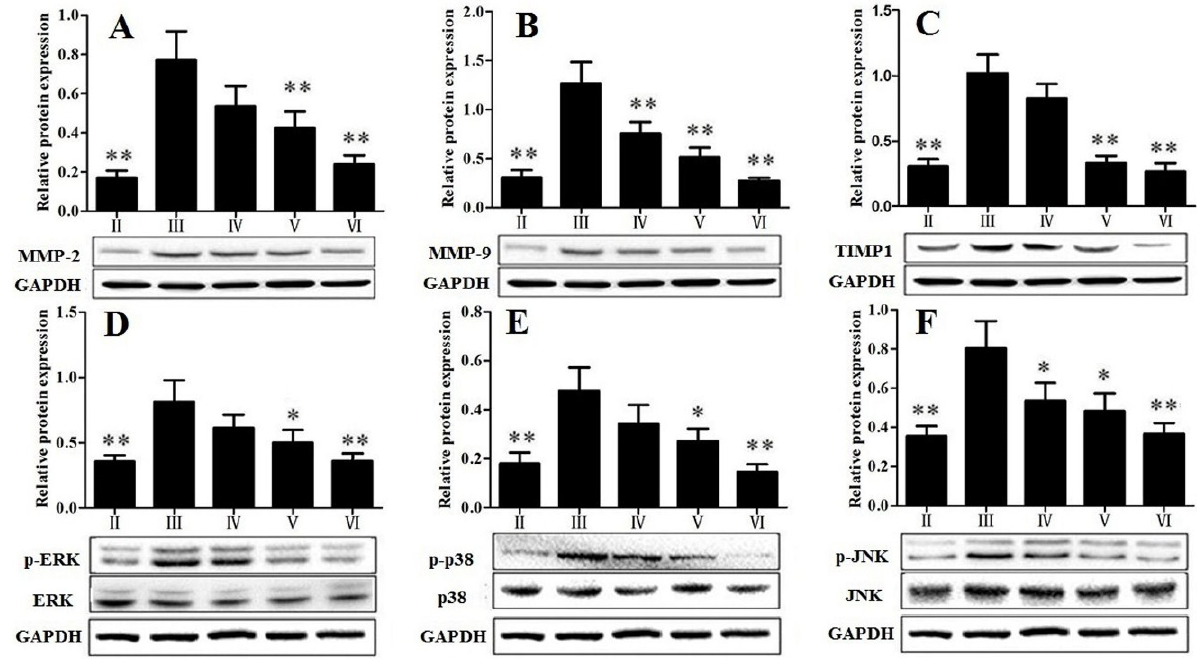
Figure 4. Effect of Rosa laevigata Michx fruit (RLTS) on the protein expressions of MMP-2 ( A ); MMP-9 ( B ); TIMP1 ( C ); p-ERK ( D ); p-p38 ( E ) and p-JNK ( F ). ( II ) Normal control; ( III ) model; ( IV ) RLTS (70 mg/kg) + CCl 4 ; ( V ) RLTS (140 mg/kg) + CCl 4 ; ( VI )